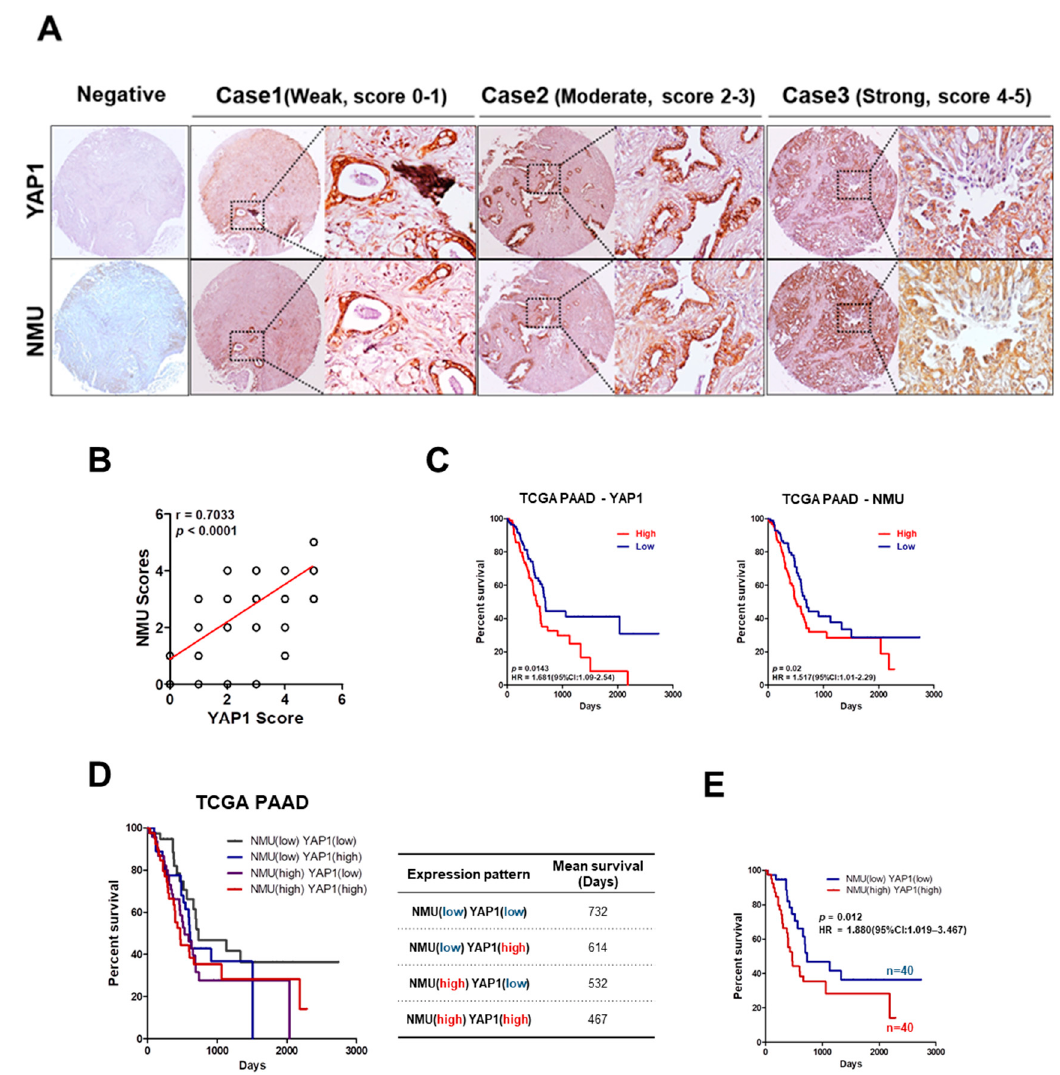
Figure 2. Clinical significance of the correlation between YAP1 and NMU expression for predicting the prognosis of pancreatic cancer. ( A ) A tissue microarray (TMA) was used to perform immunohistochemical (IHC) staining of human pancreatic cancer samples. Representative IHC images from the TMA. Scores indicated weak, moderate, and strong positive staining in tumors. Magnification: 40 × . ( B ) Correlation between YAP1 and NMU expression in the TMA. Pearson’s correlation coe ffi cient was used to quantify the correlation between the expression of YAP1 and that of NMU in tumors. ( C ) Kaplan–Meier survival analysis of patients from The Cancer Genome Atlas (TCGA) according to YAP1 and NMU expression levels; p -values derived from the log-rank test are indicated in each comparison. ( D , E ) Kaplan–Meier survival analysis and mean survival rates of patients according to YAP1 and NMU expression levels. Comparison of patients from TCGA expressing YAP1 and NMU at high or low levels; p -values derived from the log-rank test are indicated in each comparison. PAAD: Pancreas